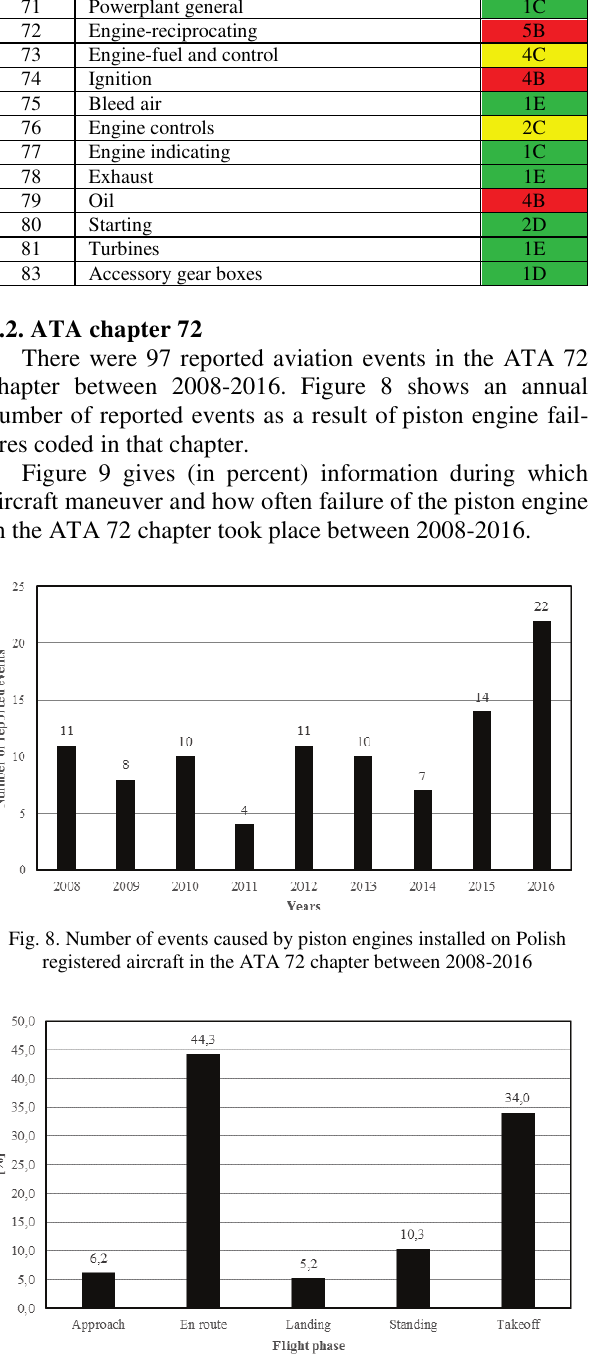
Fig. 9. Flight phases share when powerplant malfunction ATA chapter 72 took